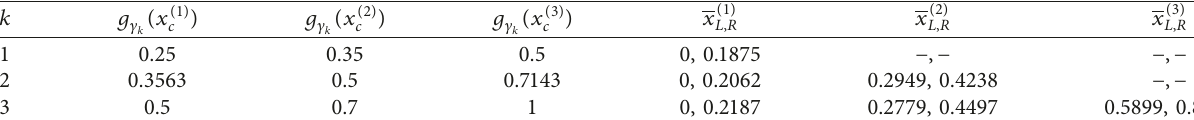
: [ 0 , 0 . 5 ] ⟶ [ 0 , 0 . 5 ] and (c) g : [ 0 , 0 . 25 ] ⟶ [ 0 , 0 . 25 ] , using c 2 � 2 . 8571 c 1 � 2 ] and [ 0 , ζ ] , for c , c , c , respectively. 2 1 3 2 1 � 2, c � 2 . 85, and c � 4. 􏽮 􏽯 3 , for c c k 1 2 3 k � 1